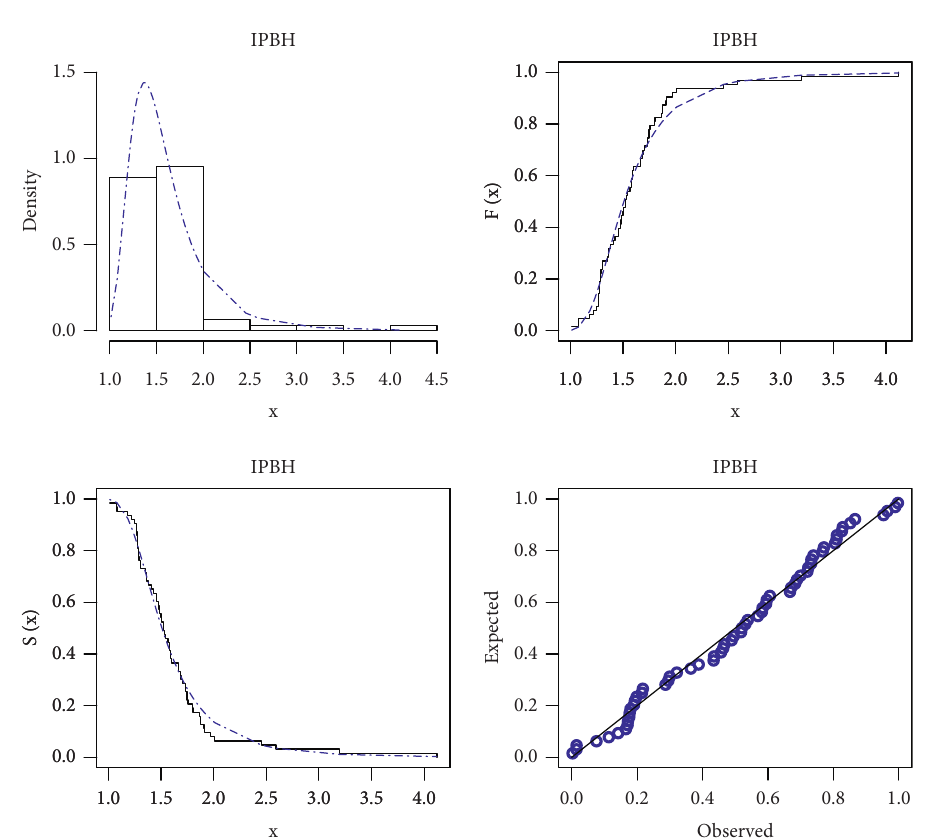
Figure 4: Histogram of dataset I with the fitted IPBH PDF, CDF, SF, and P-P